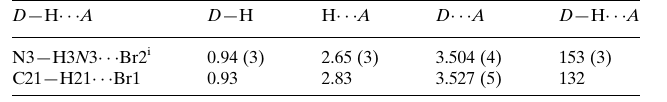
Hydrogen-bond geometry (A˚ , (cid:3)